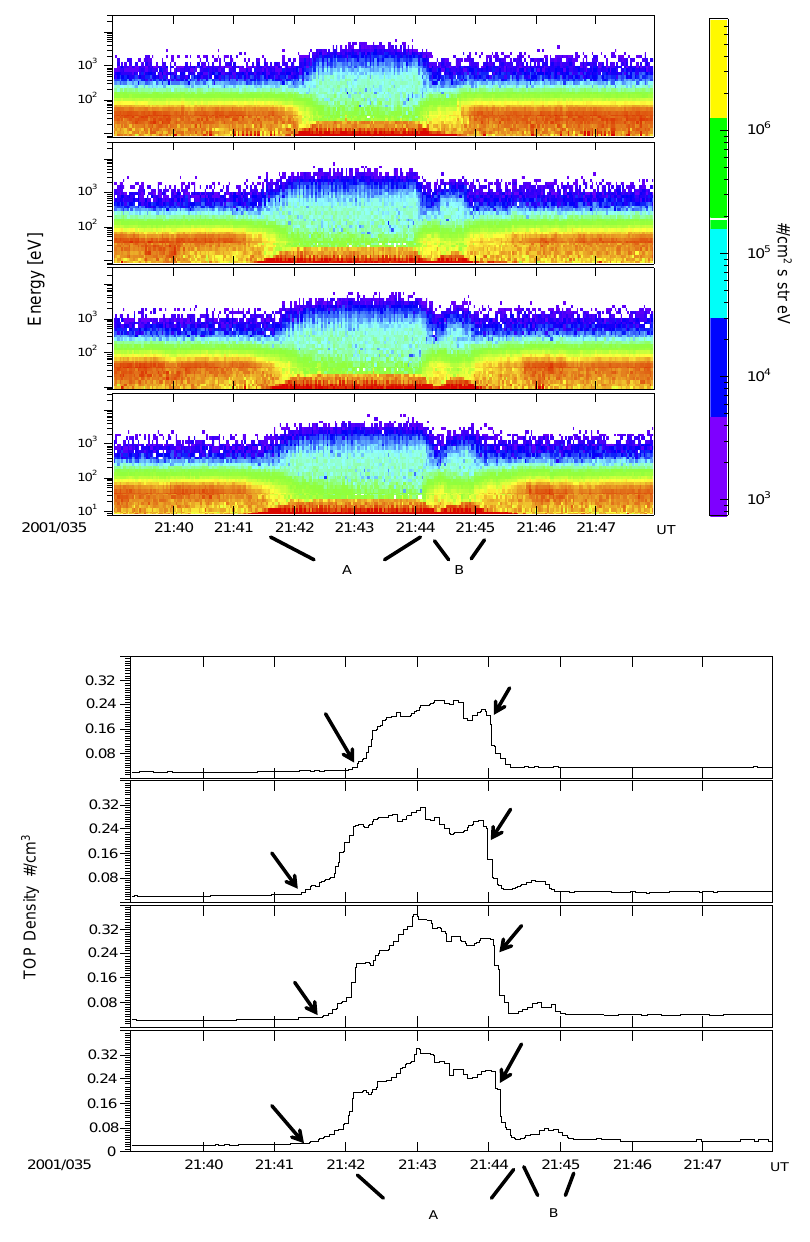
Fig. 12. The Top region of density (cal- culated from energies electrons with en- ergies of > 1keV), for time between 21:39–21:48UT, gives a good indica- tion of the extent of the high energy electron population. We use a similar method as was employed for Case 1 to achieve the entry/exit times indicated